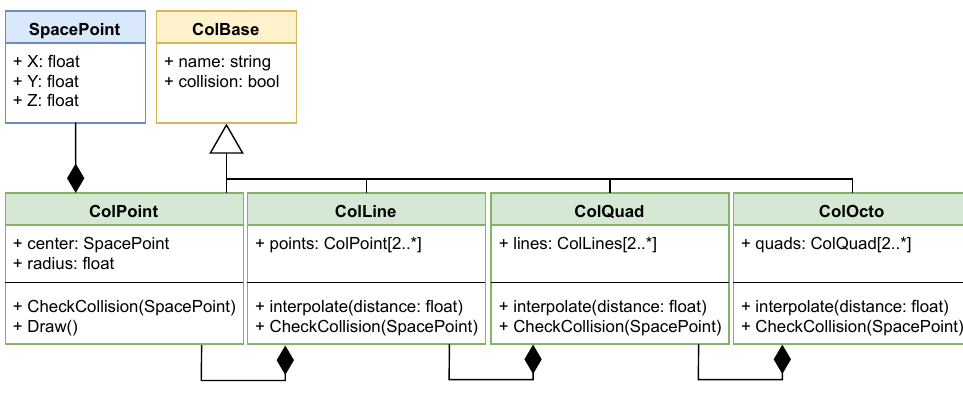
Figure 4. ColPoint Class diagram in UML. ColPoint contains a SpacePoint as a center. ColBase inherits its attributes (name and collision) to ColPoint , ColLine , ColQuad and ColOcto .